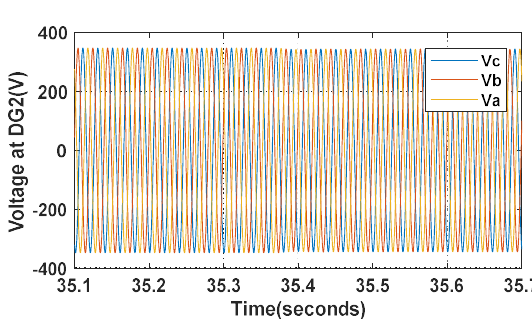
( c ) Figure 17. Experimental results for the MG in 24 h: ( a ) Scenario 1; ( b ) Scenario 2; ( c ) Scenario 3.